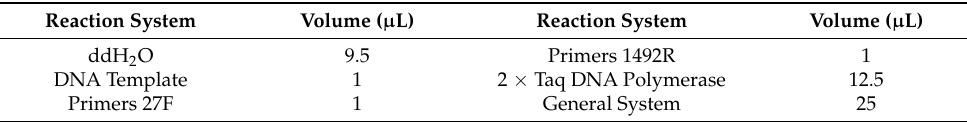
Table 1. Components of PCR